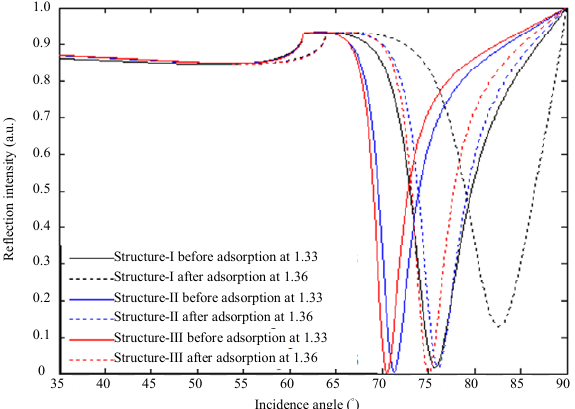
Fig. 2 Reflectance curves for structure-I, structure-II, and structure-III, at the operating wavelength 632.8 nm before and after the adsorption of biomolecules on the sensor